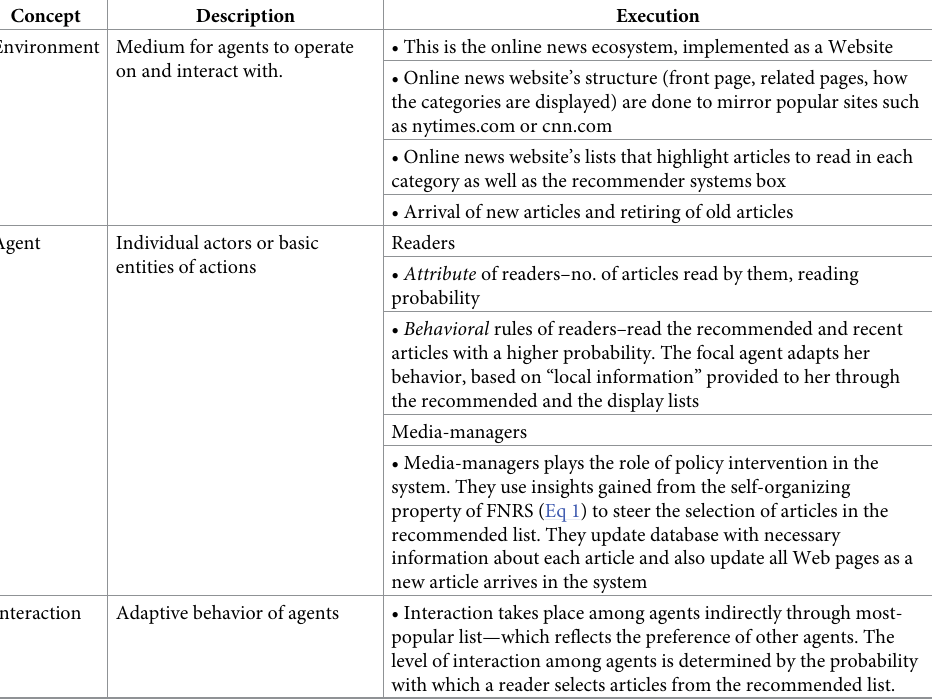
Table 1. Basic components of agent based